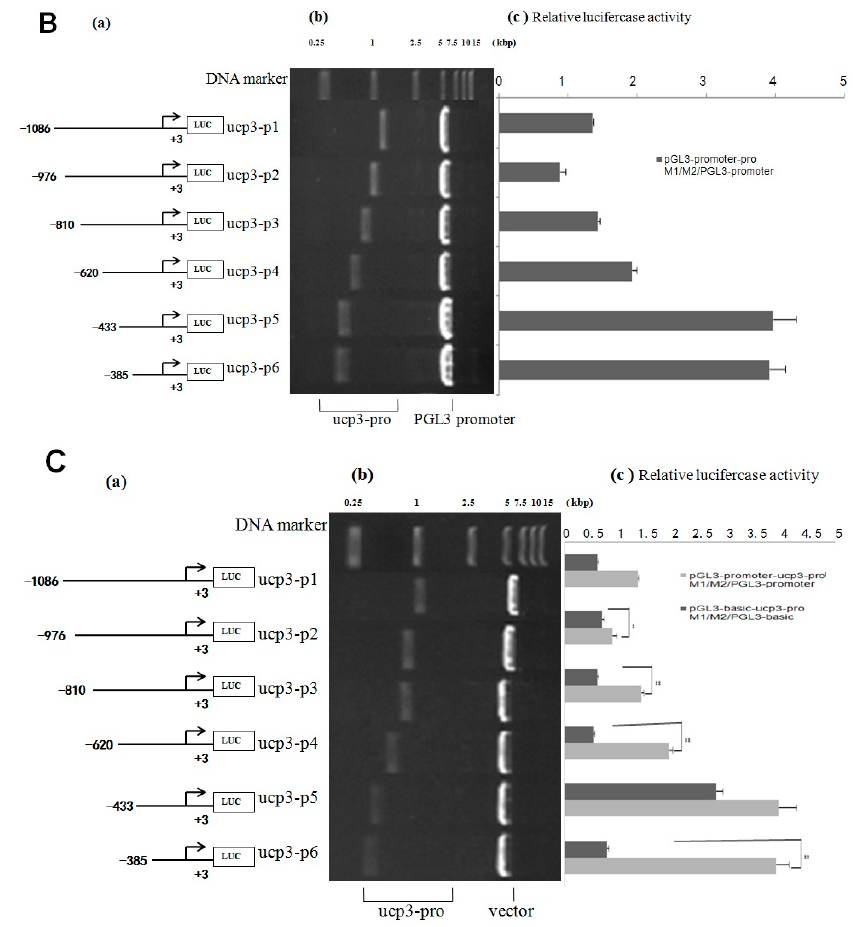
Figure 4. Deletion analysis of the cattle UCP3 promoter. ( A ) Promoter activity of the pGL3-basic-ucp3-Pro in C2C12 Cells; ( B ) Promoter activity of the pGL3-promoter-ucp3-Pro in C2C12 Cells; ( C ) Activity of the ucp3 promoter in C2C12 Cells. ( a ) Schematic diagram of the UCP3 promoter constructs consisting of the 5 ′ -flanking region with serial deletions cloned into the pGL3-basic and pGL3-promoter vector. The arrows show the direction of transcription. The numbers represent the end points of each construct; ( b ) The deletion plasmids were digested by restriction enzyme and run on a 1.5% agarose gel. The size of the vector is 4.8 kb. The inserted fragments of the UCP3 promoter range from 389 to 1086 bp which are confirmed by sequencing; ( c ) The deletion plasmids were cotransfected with pGL3-basic and pGL3-promoter into C2C12 cells; the cells were harvested 24 h later after transfection and luciferase activity was measured and expressed in relative luciferase units (RLU). The values represent means ± SE. vector represents pGL3-basic, n = 3, ** p < 0.01, by analysis of variance with one-way ANOVA.